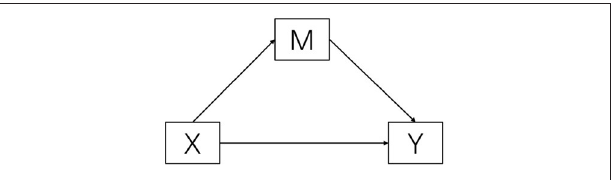
FIGURE 1 | Conceptual diagram.